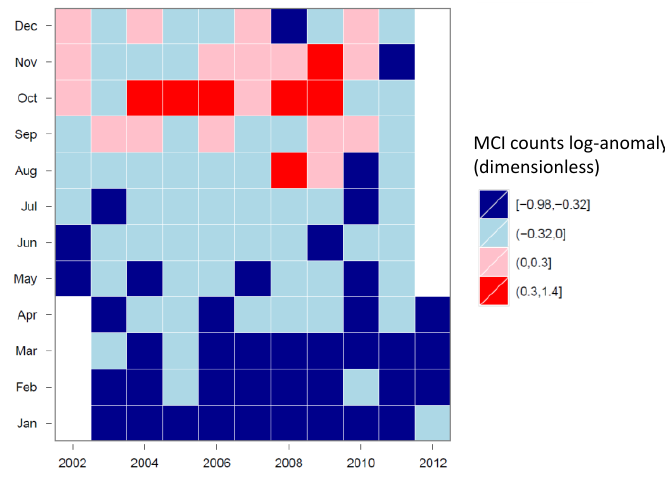
Figure 14. Tile-plot of MCI counts for the VDG cluster